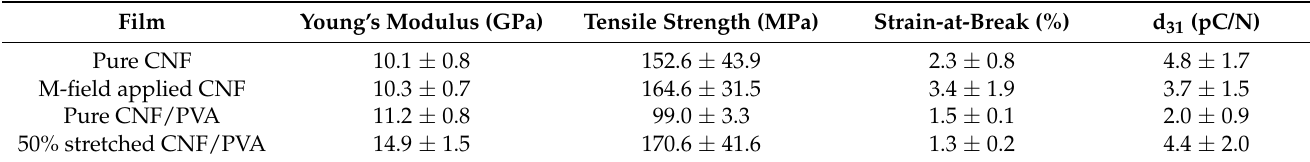
Figure 8. Stress–strain curves of prepared films. Table 1. Mechanical properties of the prepared CNF, CNF/PVA, the magnetic field applied CNF, and 50% stretched CNF/PVA films.